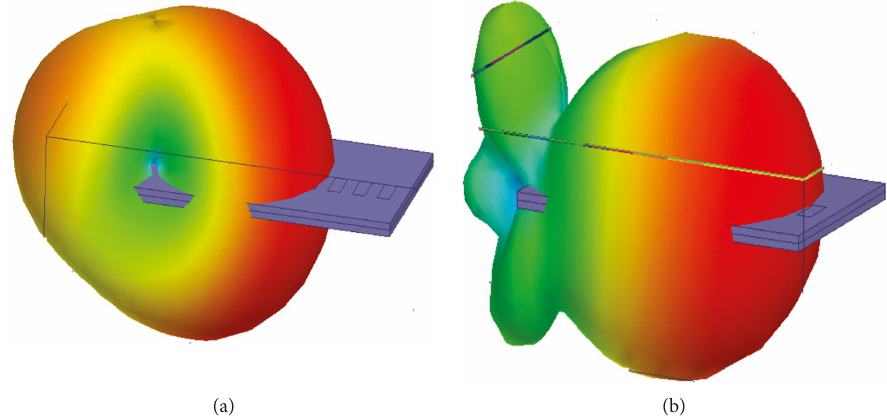
Figure 10: 3-D radiation patterns of the proposed Yagi antenna designed on Rogers 4350 substrate at di ff erent frequencies: (a) 12 GHz; (b)